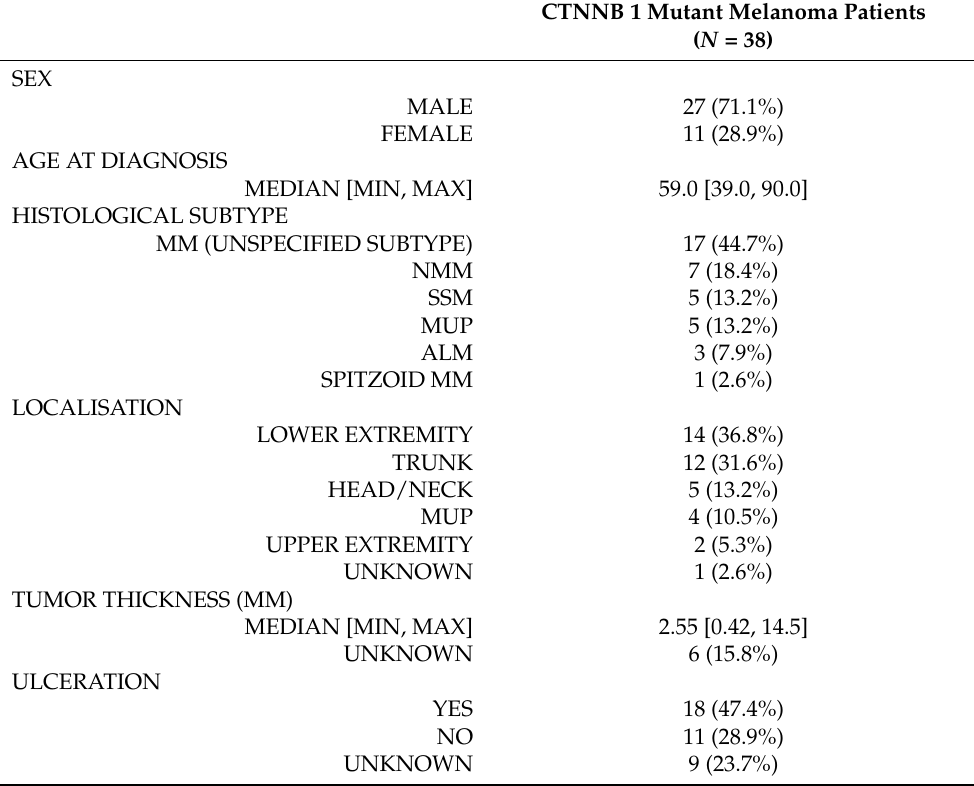
Table 2. Clinical characteristic of melanoma patients with CTNNB1